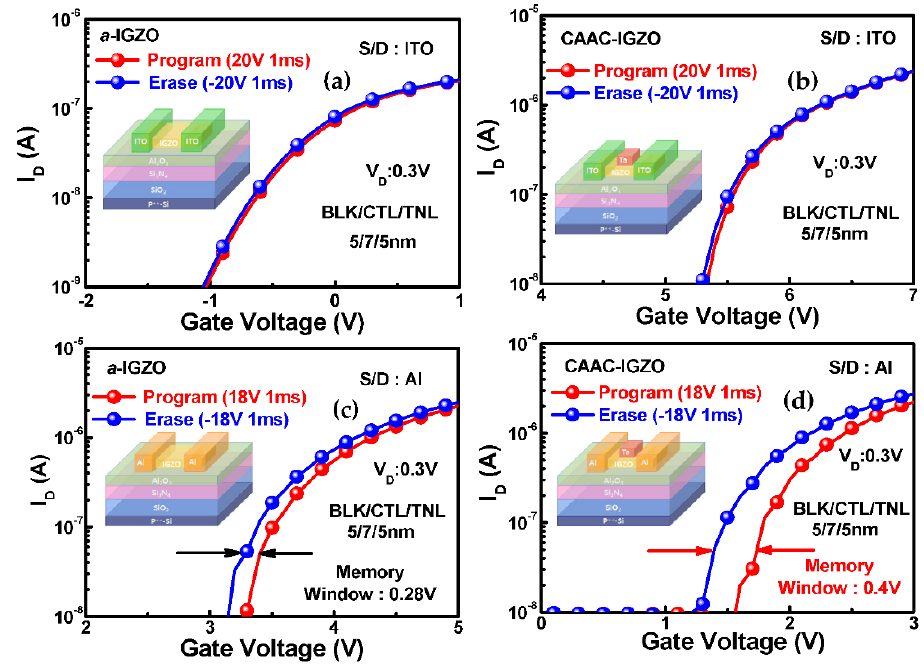
Figure 8. Transfer characteristics of the a -IGZO and CAAC-IGZO devices with different S/D materials: ( a , c ) show a -IGZO devices with ITO and Al for S/D, respectively, and ( b , d ) show CAAC-IGZO devices with ITO and Al for S/D, respectively.